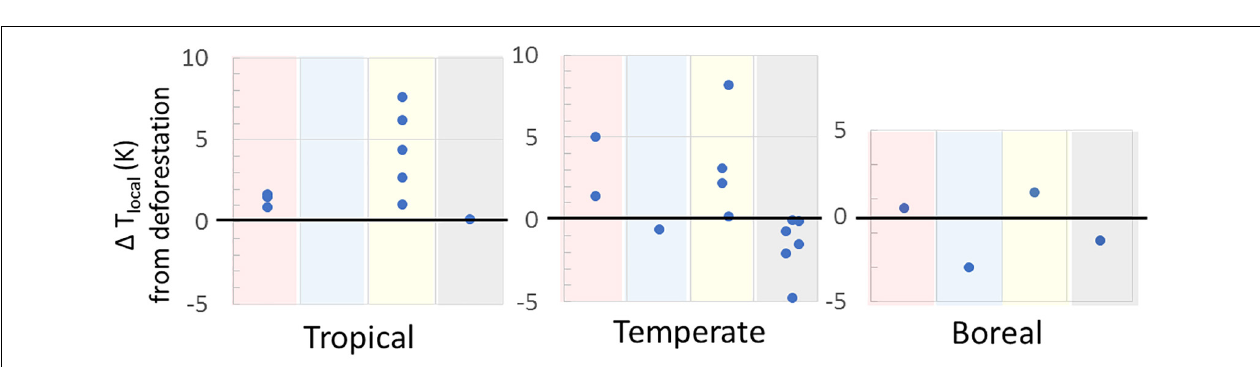
FIGURE 3 | Local temperature change in response to deforestation by season and time of day in the various climate zones as determined by comparing neighboring forested and open land (space for time approach) or measuring forest change over time. Warm/dry season response, averaged over the entire diurnal cycle, in red shading and cold/wet season response in blue shading. Daytime response, averaged over the entire annual cycle, in yellow shading and nighttime response in gray shading. See Supplementary Information 3 for data